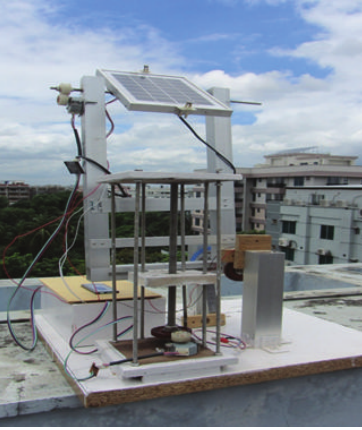
Figure 5: Experimental setup of the Hybrid dual axis solar tracker.